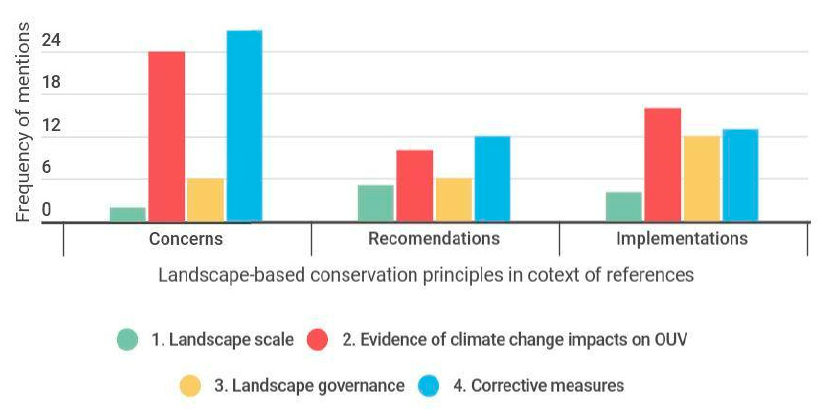
Table 2. Summary of main findings per WH